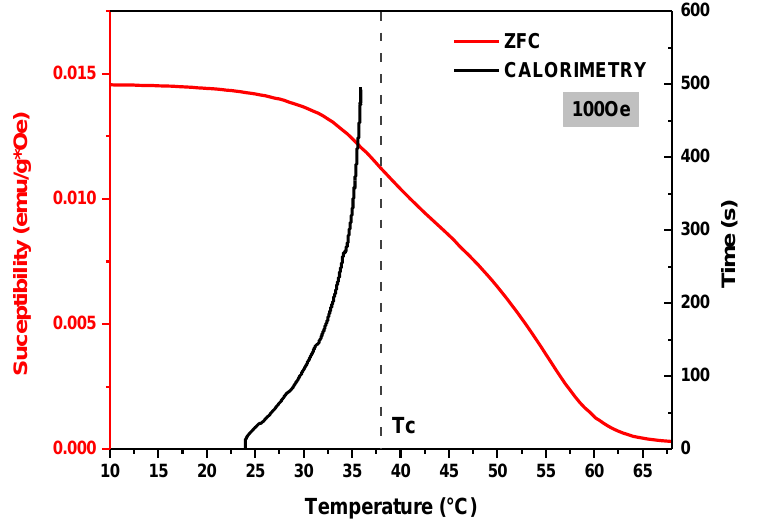
Figure 15. Thermal behavior of the LSM20 composite around Tc with a magnetic field = 100 Oe.